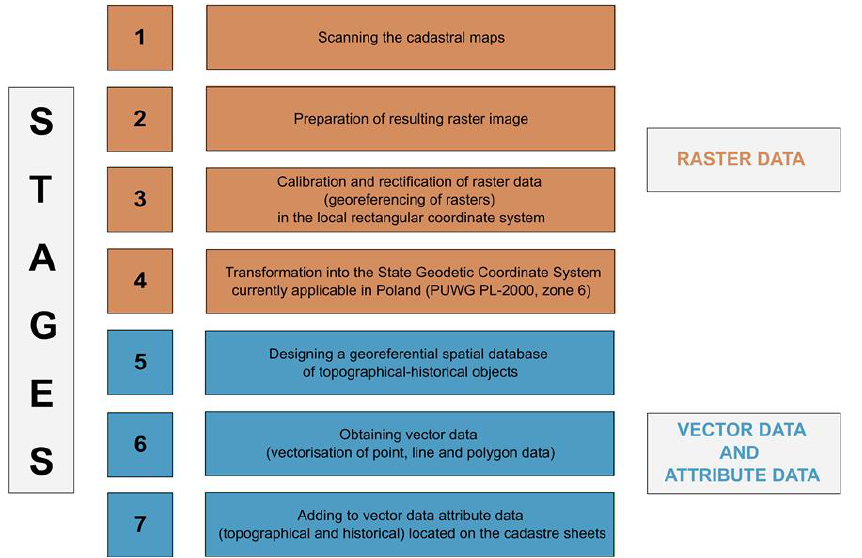
Figure 1. Stages of development of the georeferential spatial database of topographic – historical objects (GSDoT-HO).